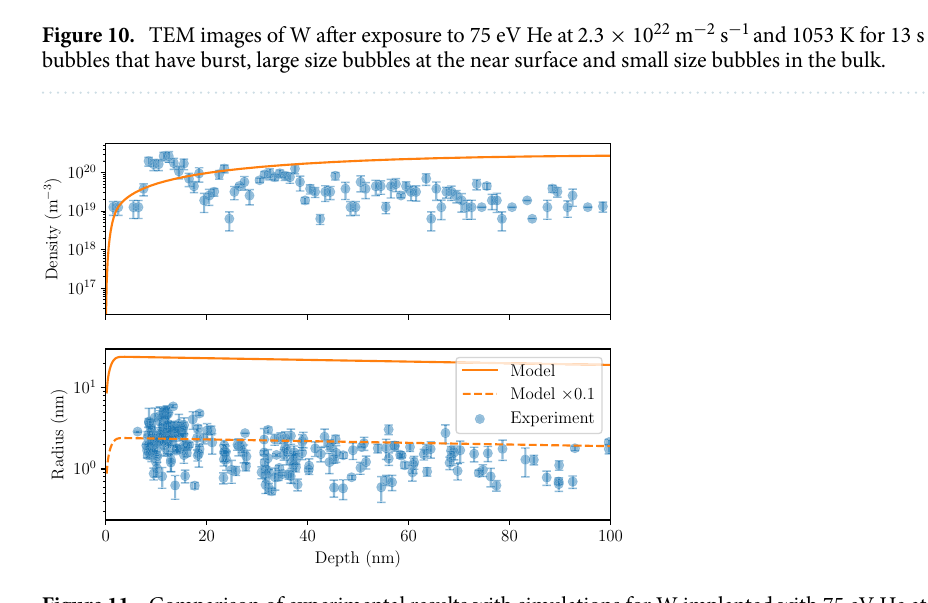
Figure 11. Comparison of experimental results with simulations for W implanted with 75 eV He at 2.3 10 22 m − 2 s − 1 and 1053 K for 13 s. Error bars correspond to the lowest and highest radius in the TEM ×